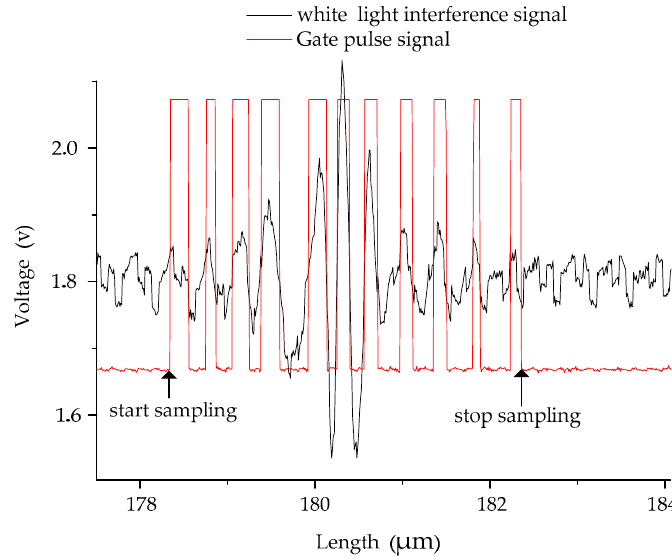
Figure 14. The shaping of white light interference signal.